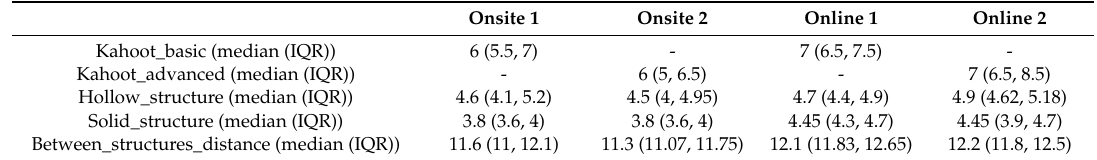
Table 2. Scores obtained in the di ff erent